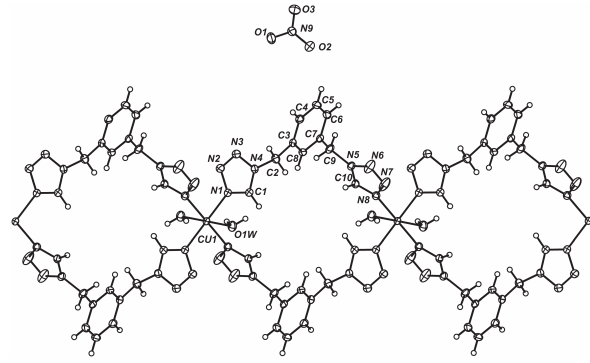
Table 2: Fractional atomic coordinates and isotropic or equivalent isotropic displacement parameters (Å 2